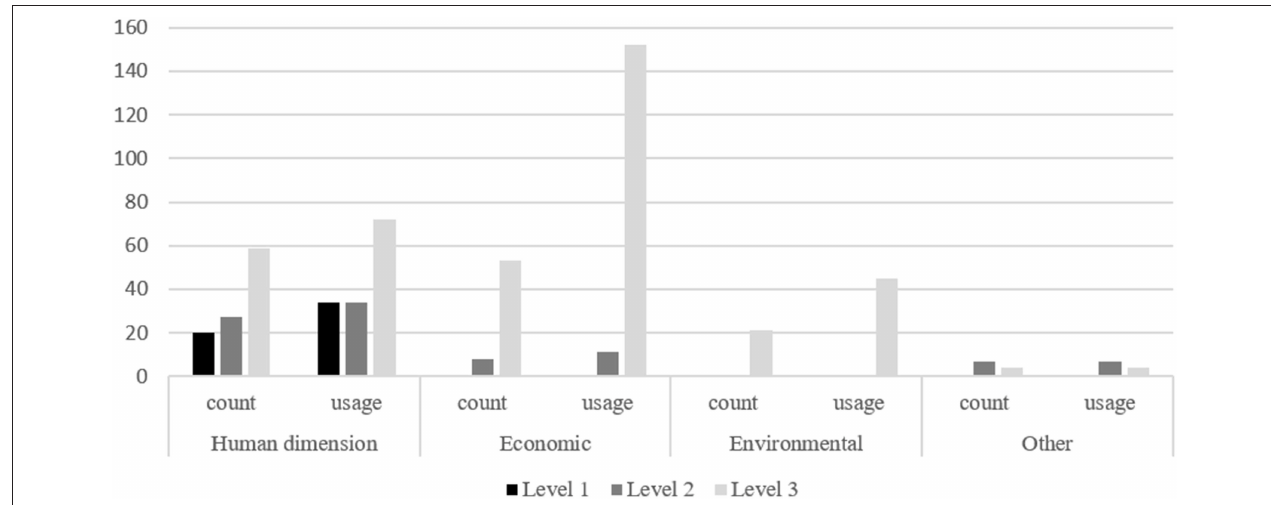
FIGURE 2 | Occurrence and usage of variables for all three levels, from the four different dimensions human, economic, environmental , and other . Count indicates the number of different variables identified for each level and each dimension. Usage indicates the number of times that variables from each dimension were used. Other includes variables that could not be categorized within the three dimensions, human, economic, and environmental, such as time .